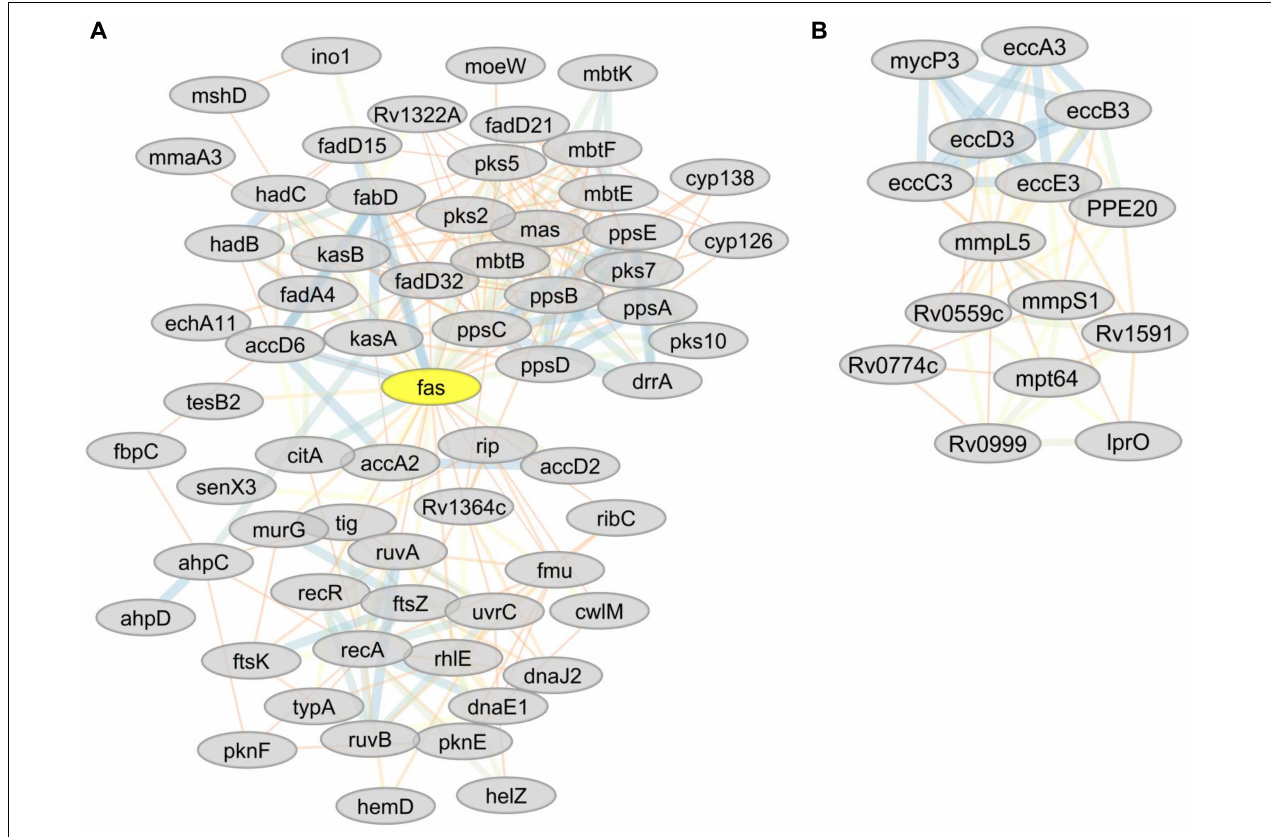
FIGURE 5 | (A) Predicted sub-network interactions for differentially abundant proteins (RecA, FaS, FabD, PssD, and PssC) representing important protein hubs. (B) Predicted sub-network interactions for differentially abundant proteins involved in type VII ESX-3 secretion system (iron acquisition).